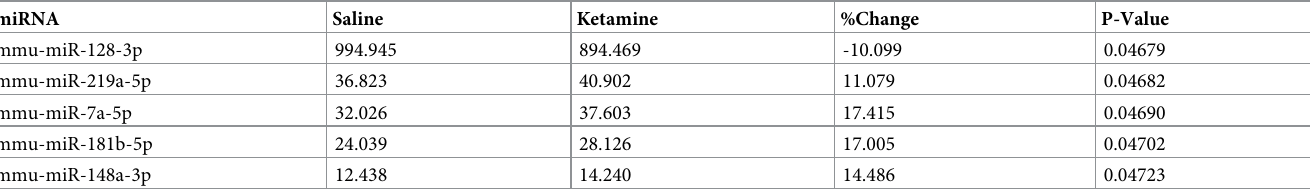
Values in Saline and Ketamine represent raw count.